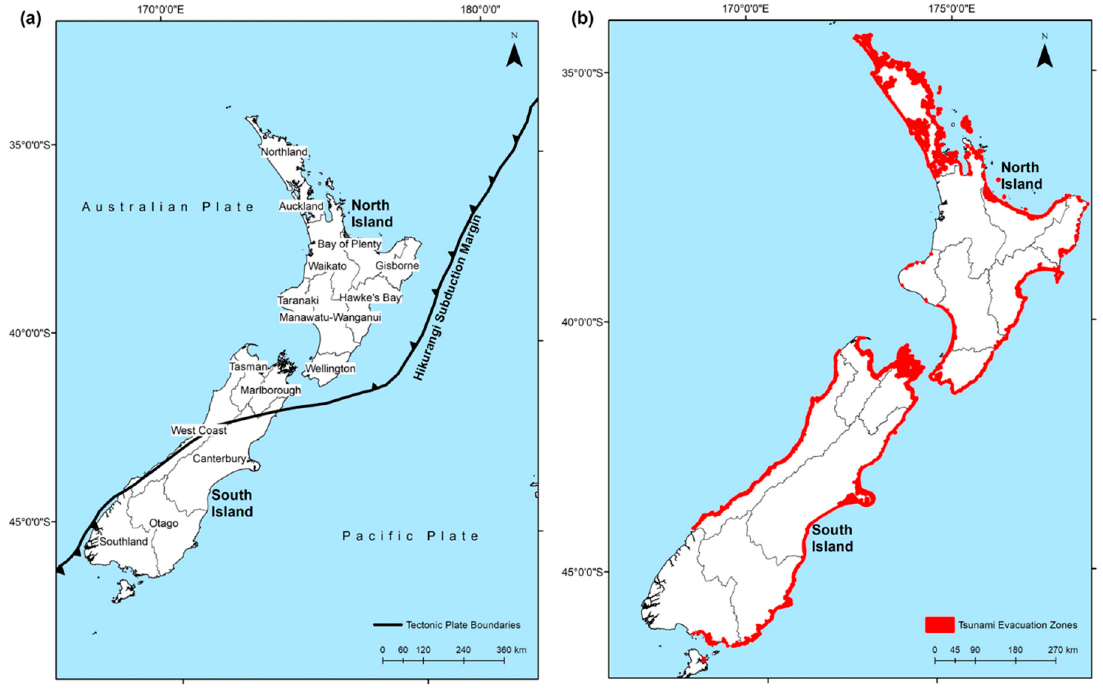
Figure 1. ( a ) New Zealand regional authority boundaries and ( b ) coastline coverage with mapped tsunami evacuation zones.